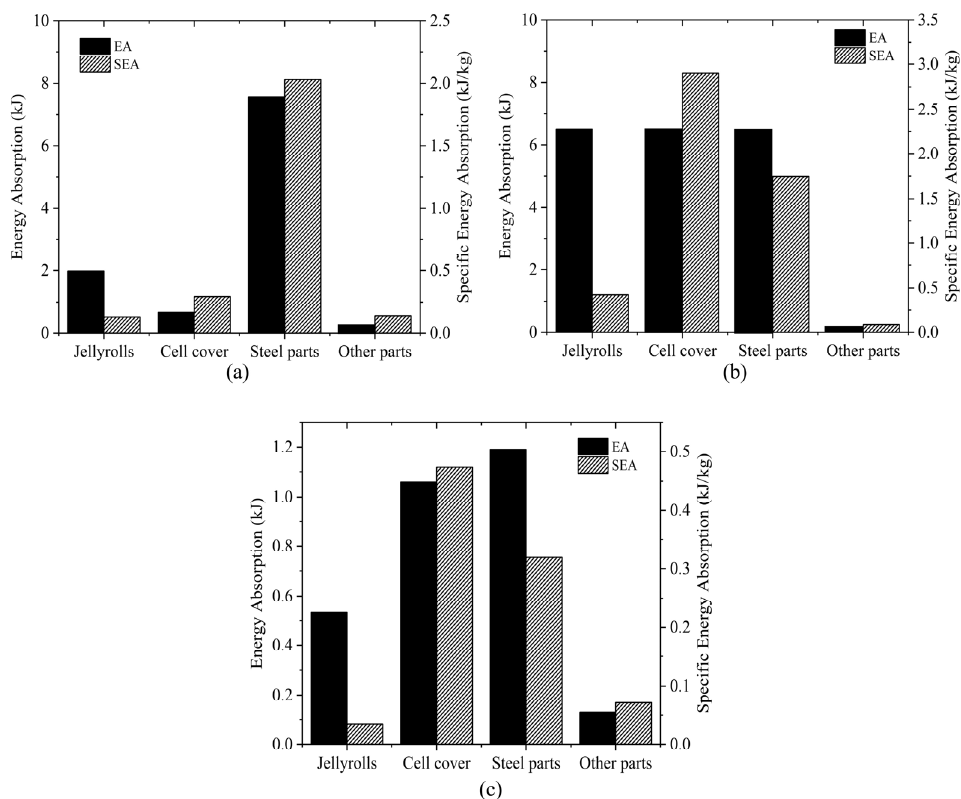
Figure 8. Energy absorbed by various battery module parts during wedge indentation at 0.05 mm/s: ( a ) Case 1; ( b ) Case 2; and ( c ) Case 3.